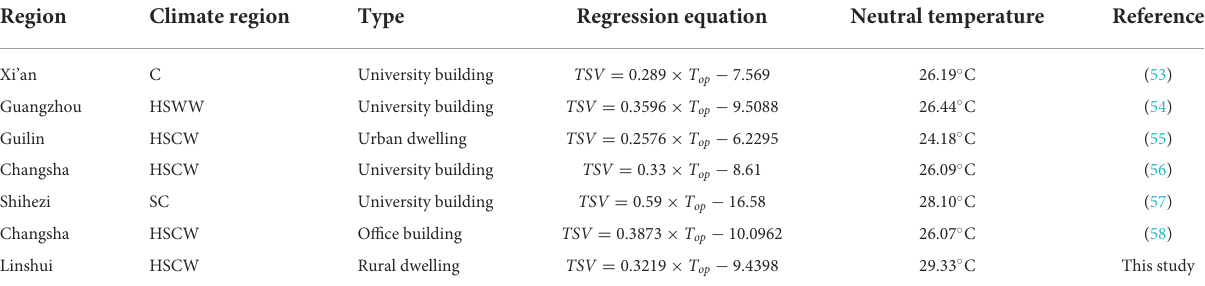
TABLE 5 Comparison of this study and other